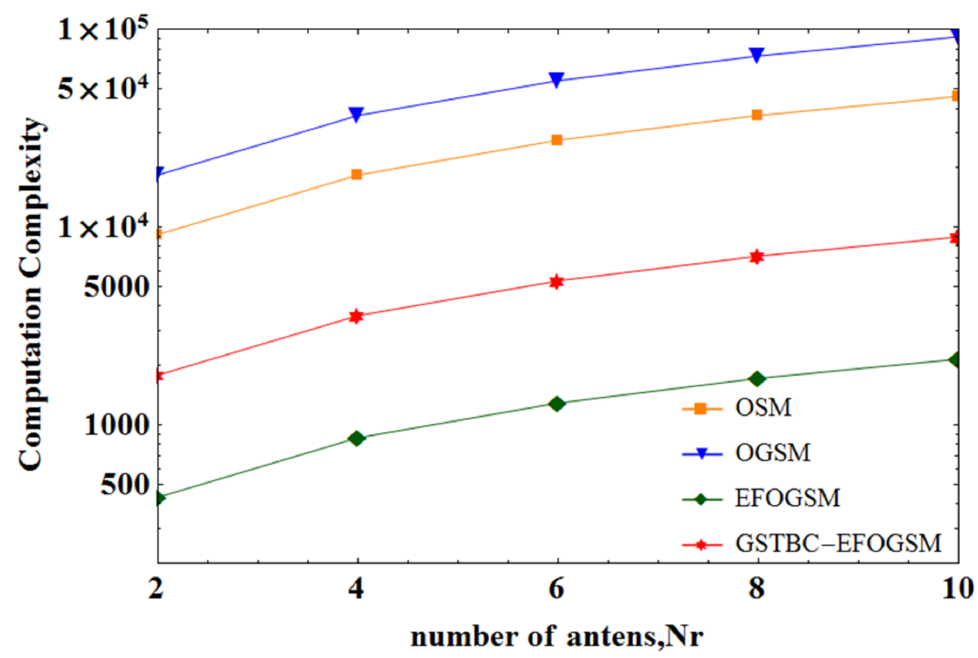
Figure 8. Computational complexity of the receiver under different optical spatial modulation